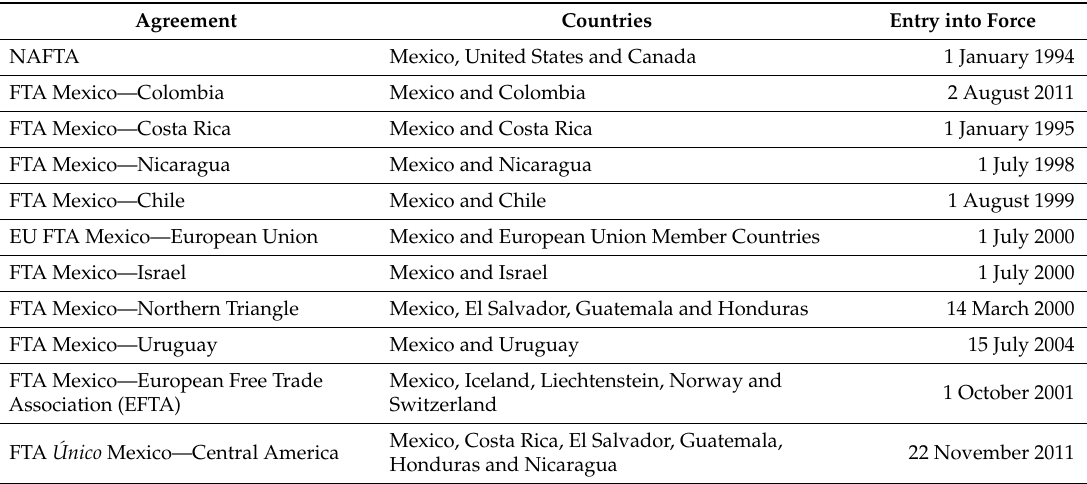
Table 5. Selected Free Trade Agreements in force in